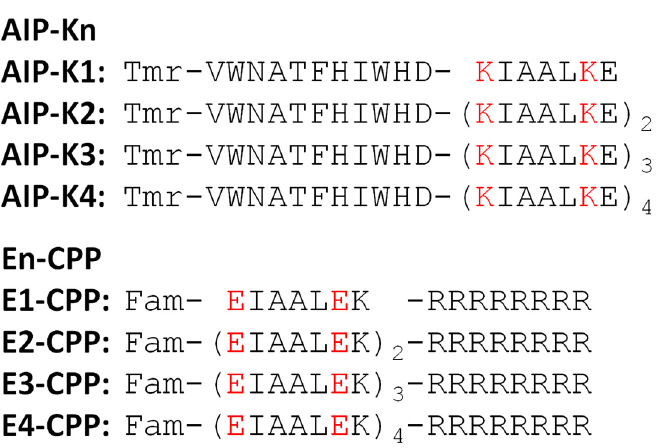
Figure 1. Sequences of eight fluorescently labeled coiled-coil peptides, AIP-Kn and En-CPPs (n = 1–4). The red letters indicate the charged amino acids critical for the formation of a 1:1 hybrid between Kn and En peptides. Tmr and Fam stand for the fluorescent dyes tetramethylrhodamine and fluorescein, respectively.